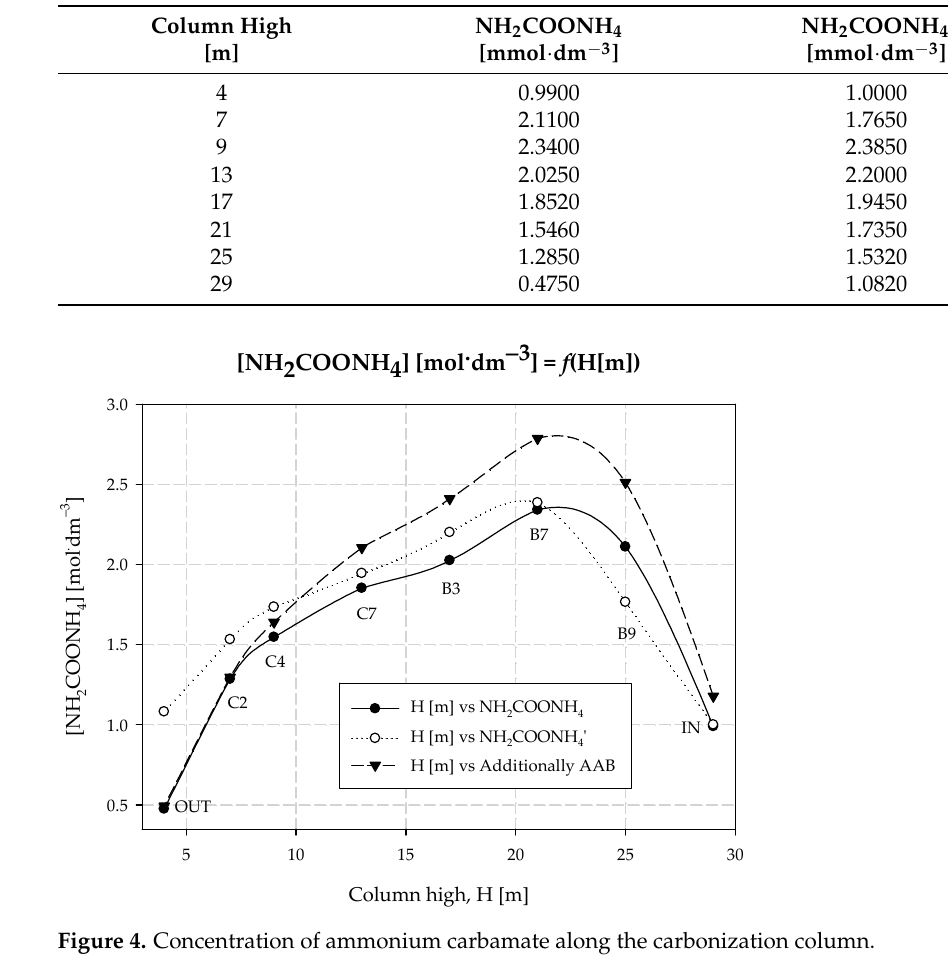
Figure 4. Concentration of ammonium carbamate along the carbonization column.